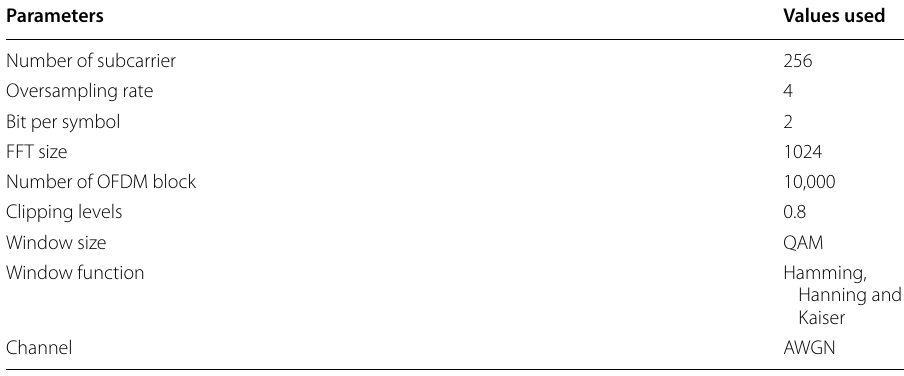
Hanning and Kaiser